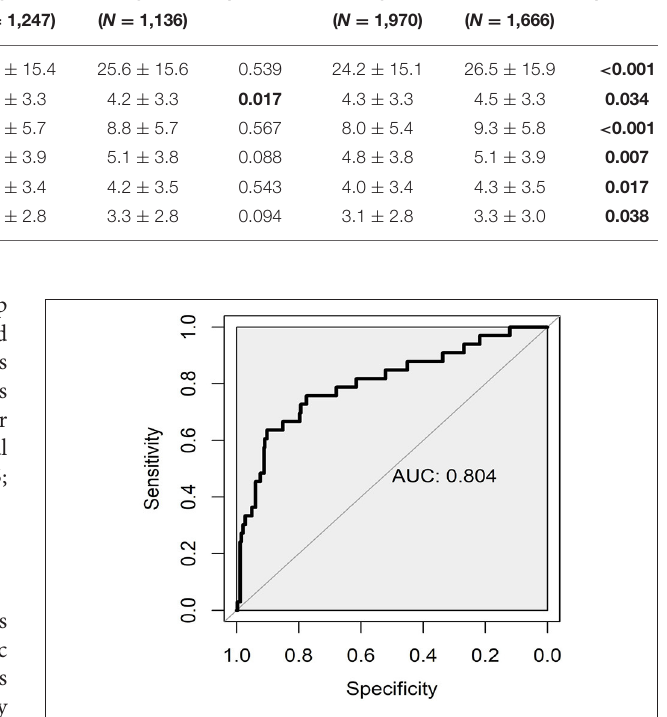
FIGURE 1 | Receiver operating characteristic curves (ROC) for the predictive performance of regression model of anxiety